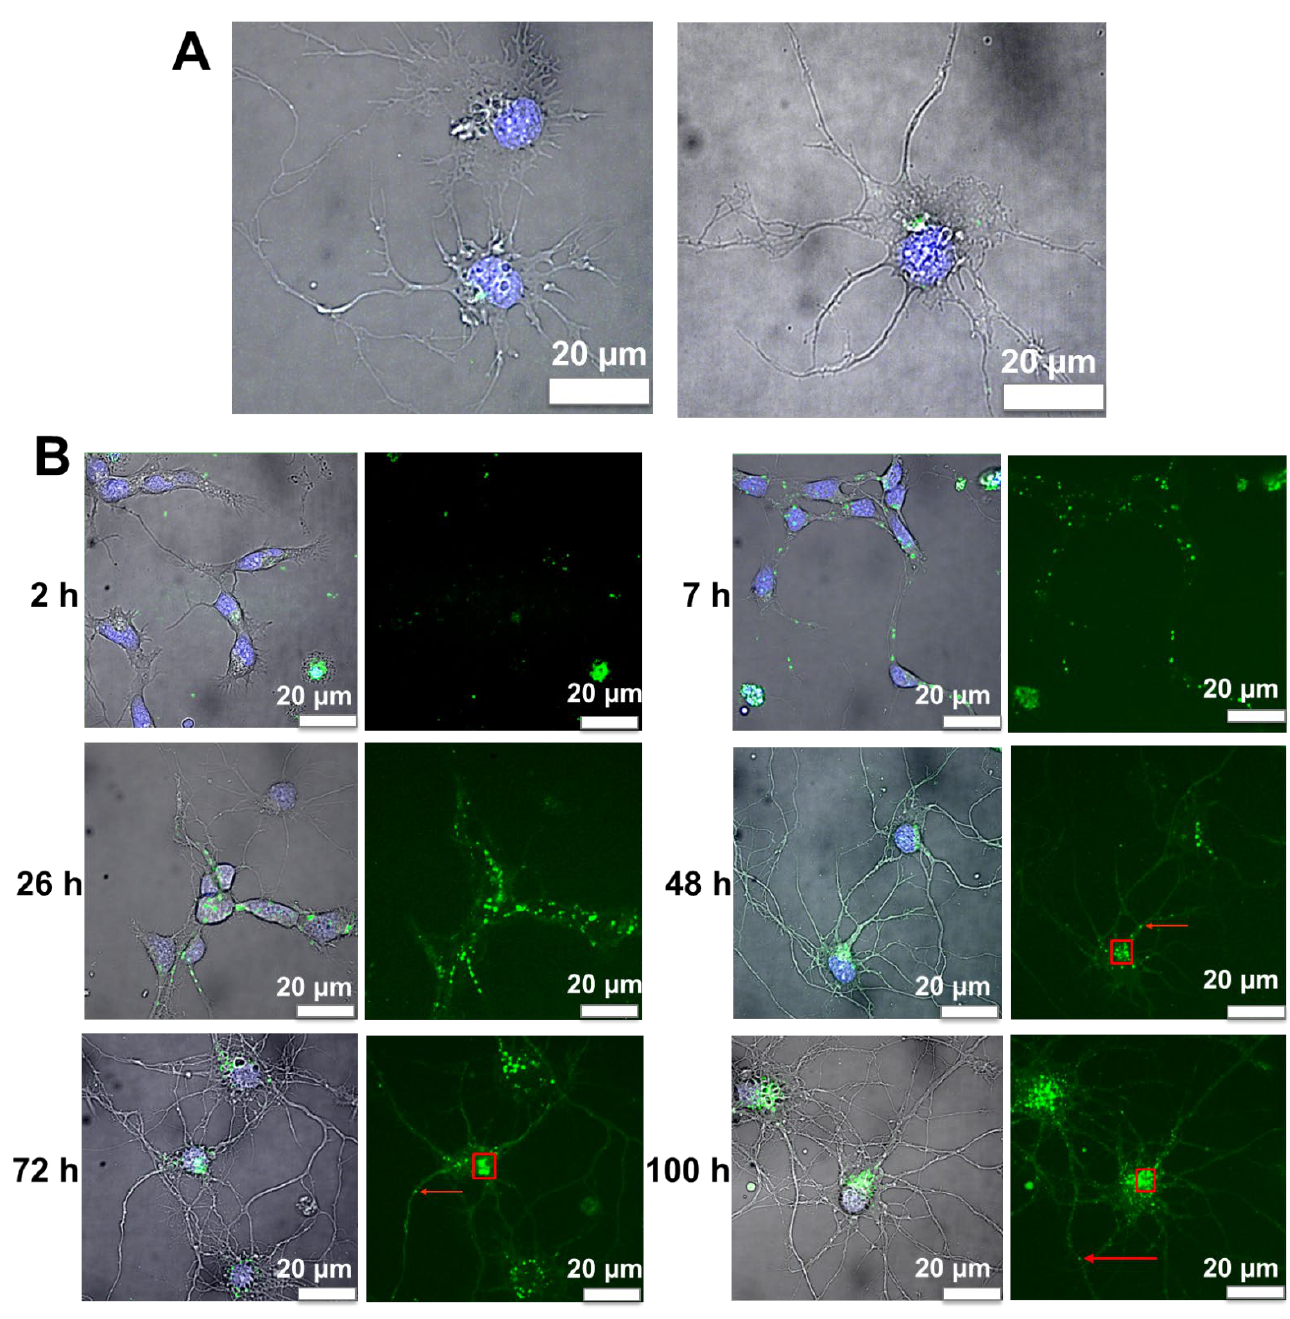
Figure 3. Representative images of primary cortical neurons treated with NL. ( A ) Representative images of NL after 3 h of incubation (merge) showing NL labeled with ATTO 488 (green) and DAPI- labeled nuclei (blue); scale bar: 20 µm. ( B ) Representative images of primary cortical neurons treated with NL labeled with ATTO 488 (green) at 2, 7, 26, 48, 72 and 100 h of incubation. Nuclei are labeled with DAPI (blue) (scale bar: 20 µm). The left panels of each time point are merge images to show both DAPI and ATTO 488 labels. The red boxes and arrows represent examples of cell bodies and extensions/dendrites, respectively.